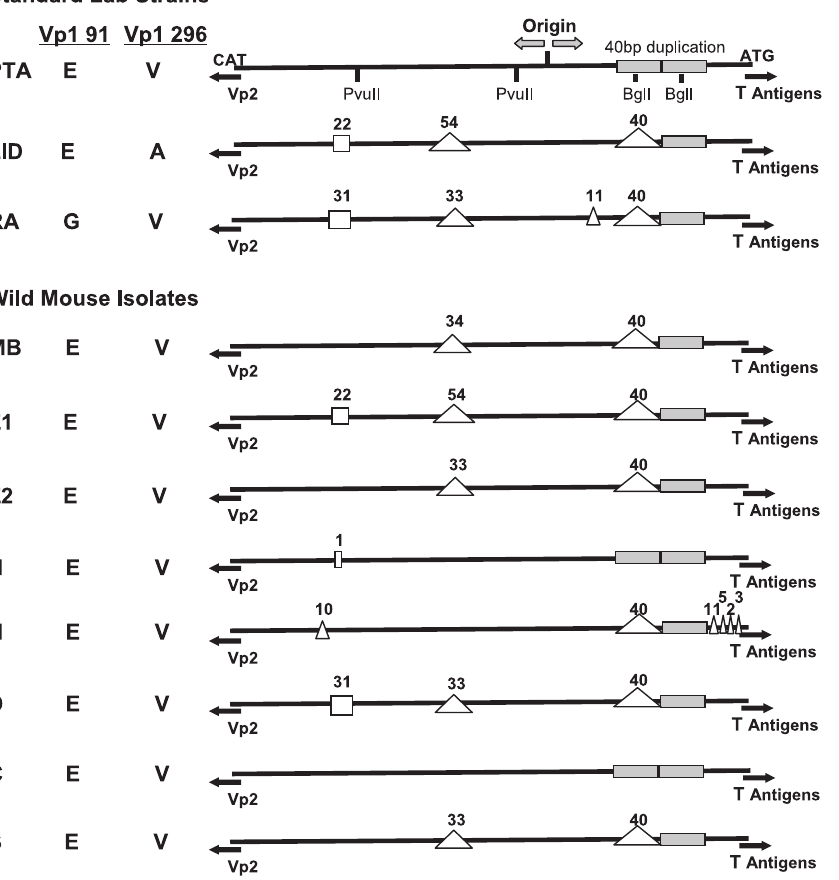
Figure 2. Origin Regions of Three Standard Polyoma Laboratory Strains and Eight Polyoma Isolates from Feral Mice Amino acids at positions 91 and 296 of Vp1 are shown on the left. The origin regions on the right are denoted schematically as horizontal lines representing the sequences between the start sites for Vp2 (CAT ‹ ) and the T antigens (ATG fi ). The PTA sequence on the top is used as a reference. The bidirectional replication origin ( ‹fi ) and the PvuII and Bgl1 restriction sites are shown as points of reference. The 40–base pair duplication at the Bgl1 sites in PTA is designated with shaded rectangles. Insertions and deletions are denoted by open boxes and open triangles, respectively, along with the number of base pairs.